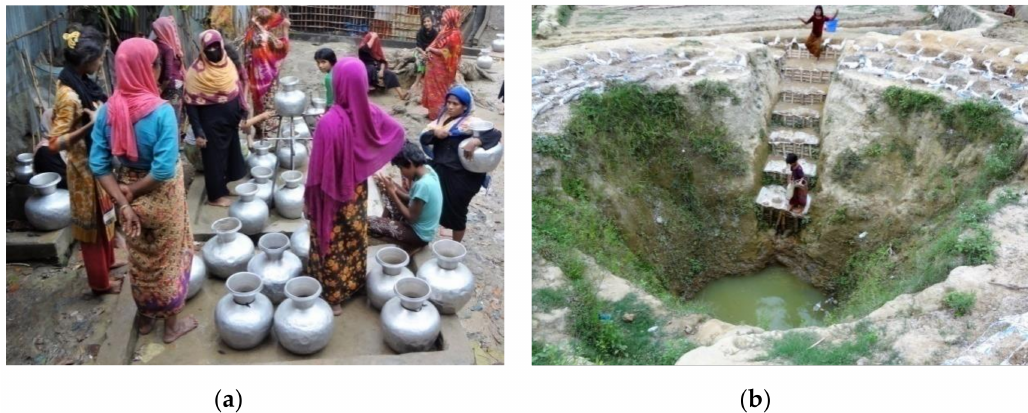
Figure 3. ( a ) Water collection by women and children in Camp 4; ( b ) Water collection by children in Camp 22.